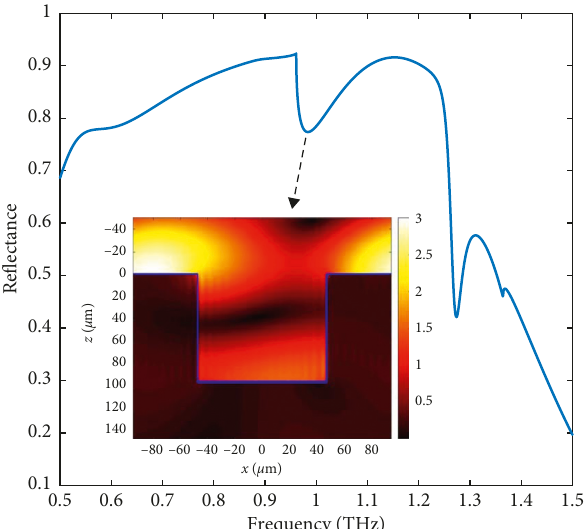
� 100nm at the incident angle of 10 ° as a m